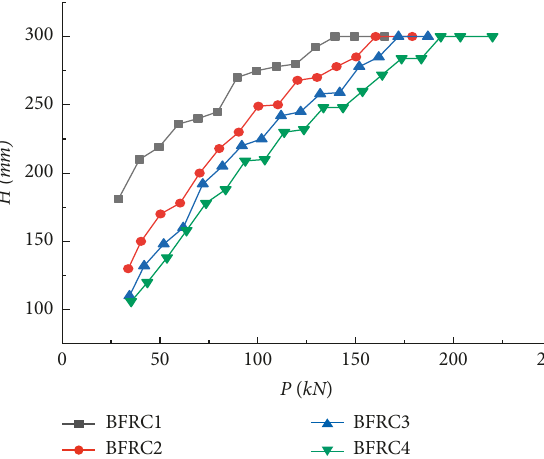
Figure 9: Load-maximum crack height curves under different steel fiber concrete